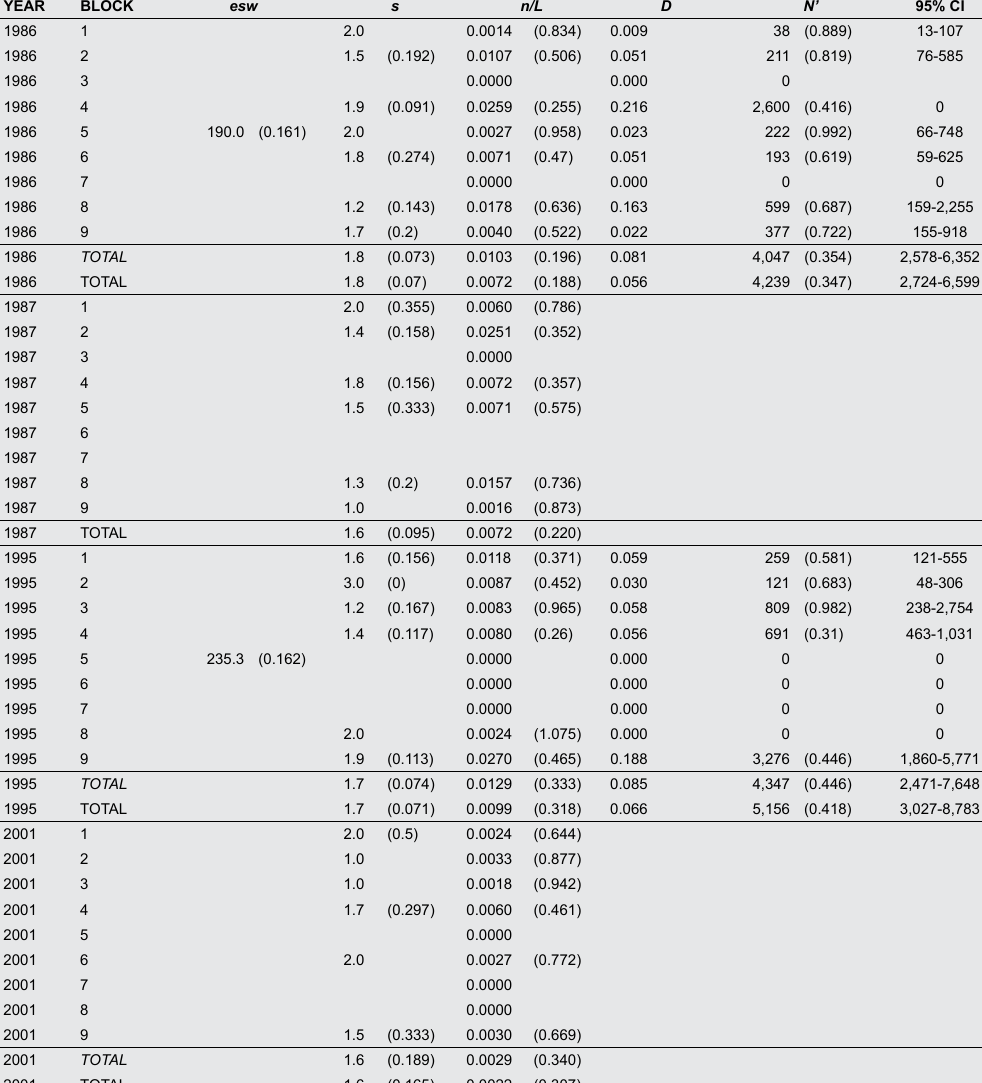
Table 7. Abundance estimates of harbour porpoise, from Icelandic aerial surveys, 1986-2001. Symbols as in Tables 4 and